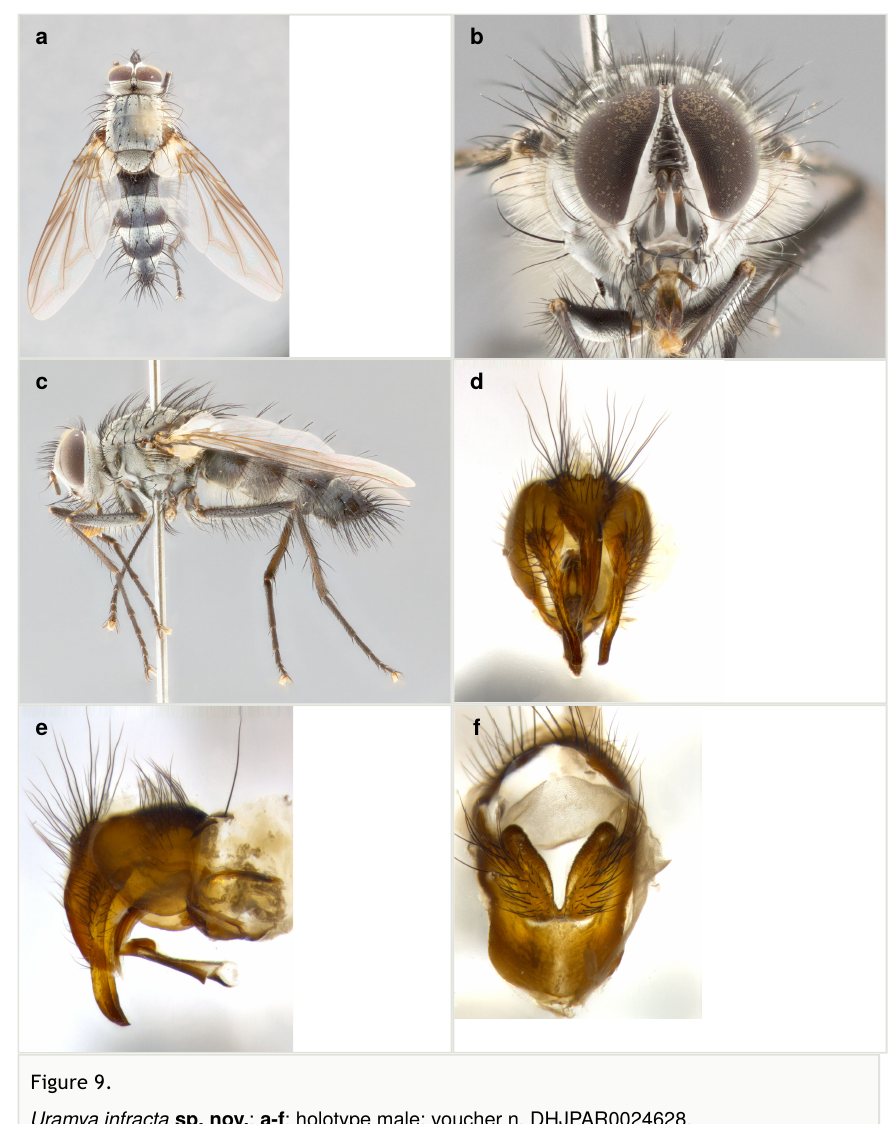
Uramya infracta sp. nov. ; a-f : holotype male; voucher n.